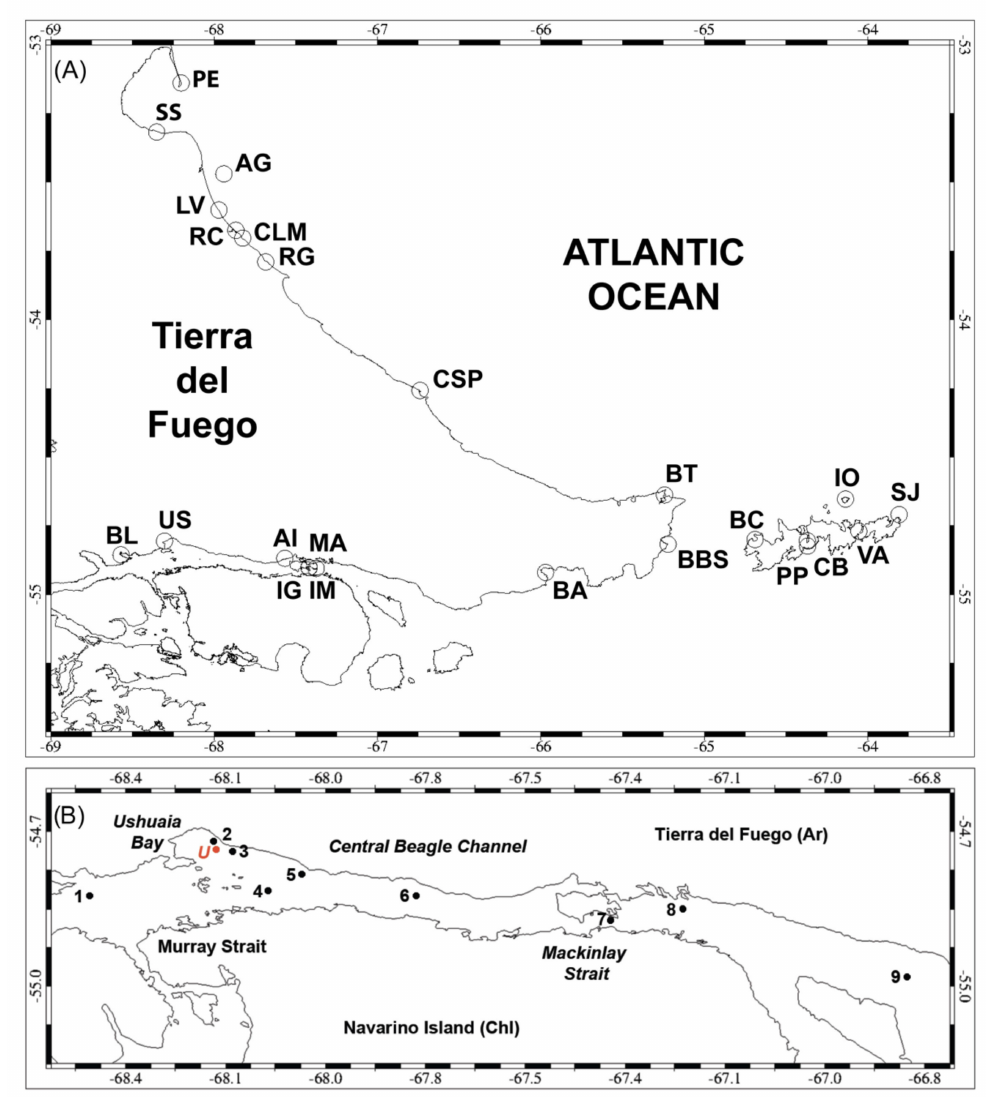
Figure 3. Locations of the tidal stations along the Argentinian coastline used for model calibration ( A ). Locations of the LADCP measuring stations ( B , black dots from 1 to 9) and of the moored current-meter in Ushuaia Bay ( B , red dot with label